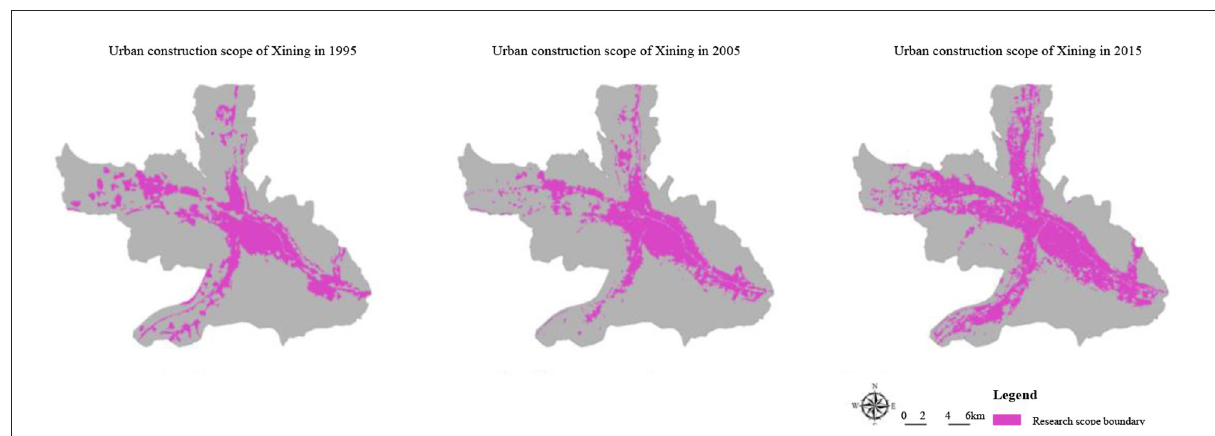
FIGURE7 Remote sensing analysis of urban construction land in